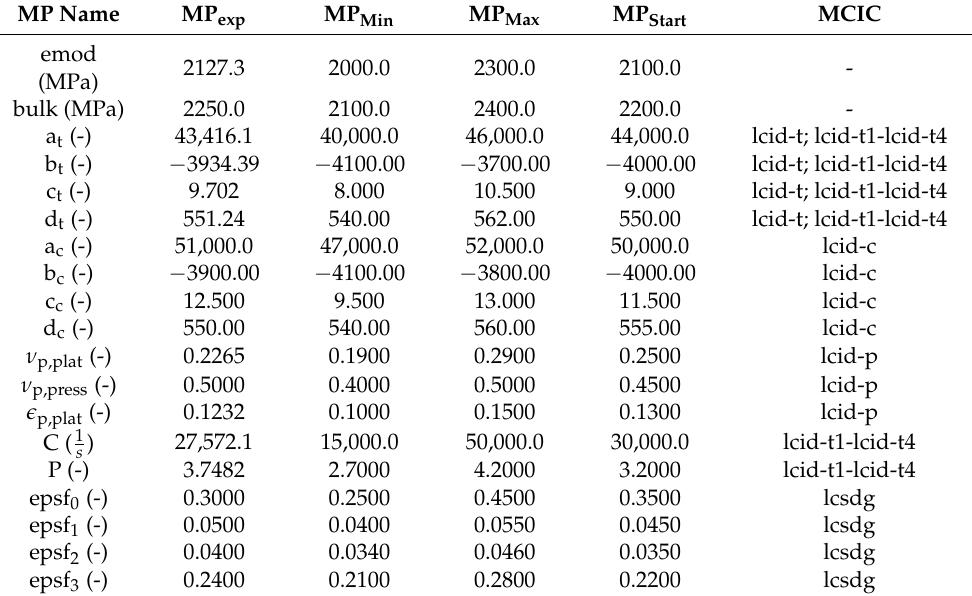
Table 1. Material parameters of the virtual experimental dataset and the corresponding MP ranges for the applied MPI methods. Additionally, the starting values for the optimization-based MPI method and the corresponding material card input curve names are